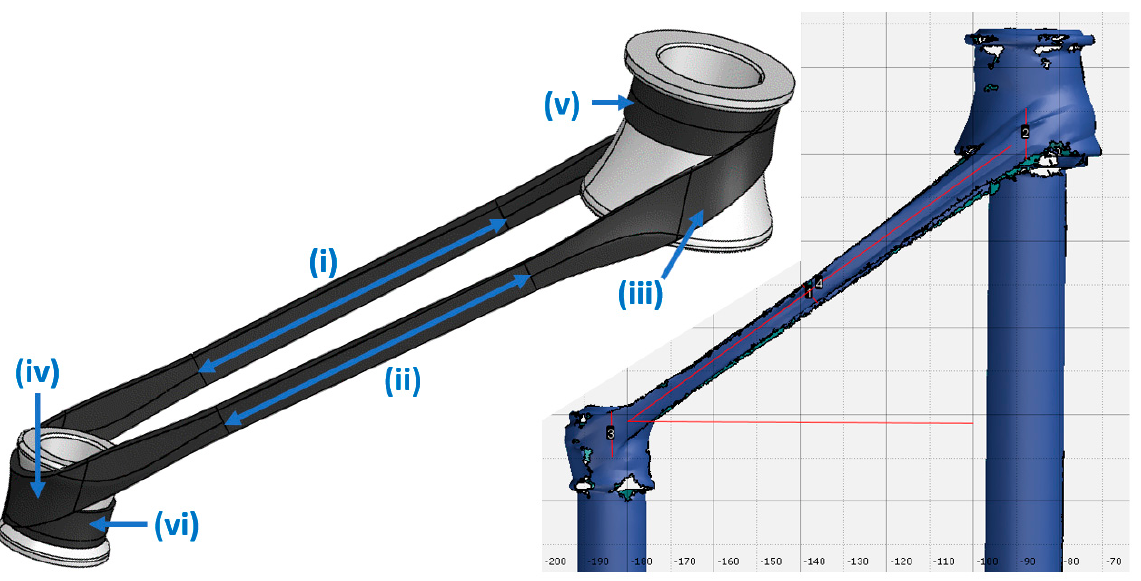
Figure 8. Macroscopic geometry model of the inclined loop with characteristic areas ( left ), screenshot of the 3D measuring ( right ). Table 3. Characteristic dimensions and locally present winding numbers of the inclined